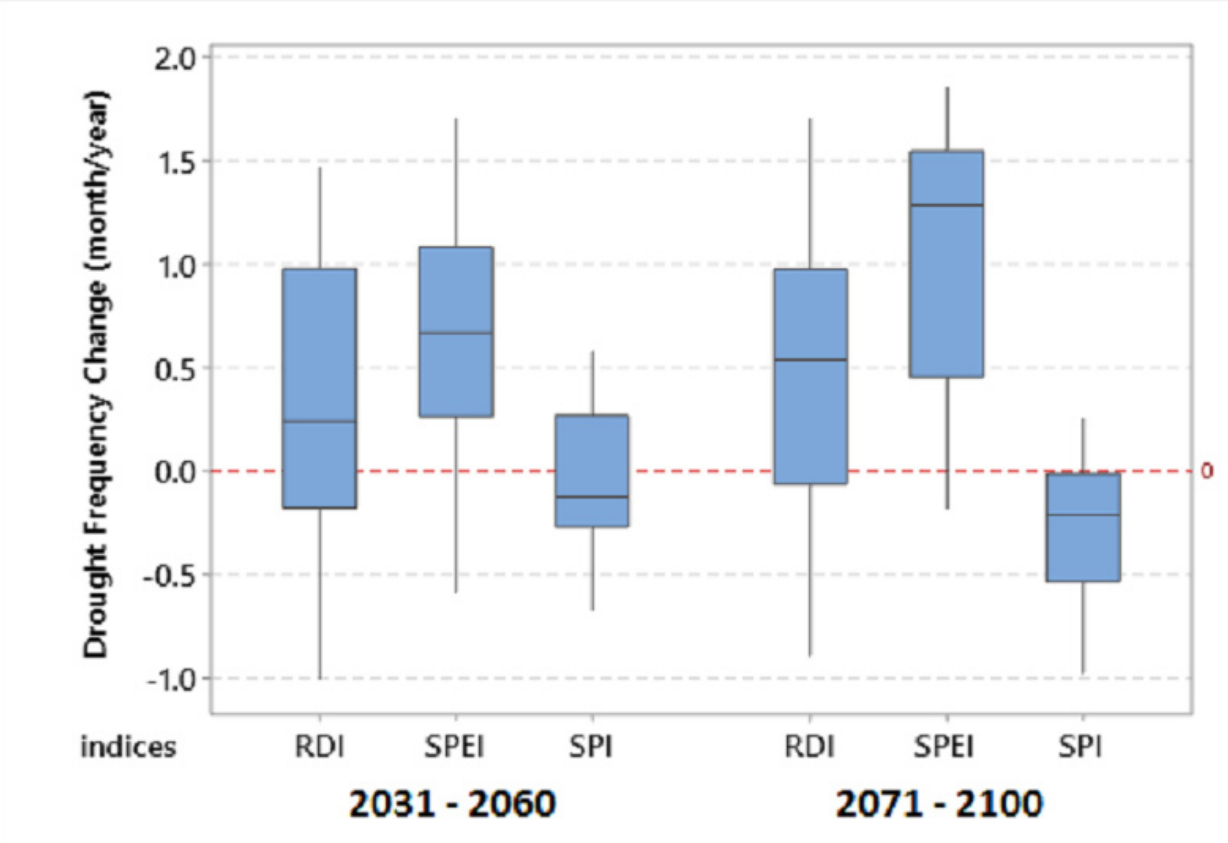
Figure 6. Projected future changes in 12-month drought frequency over Nigeria.